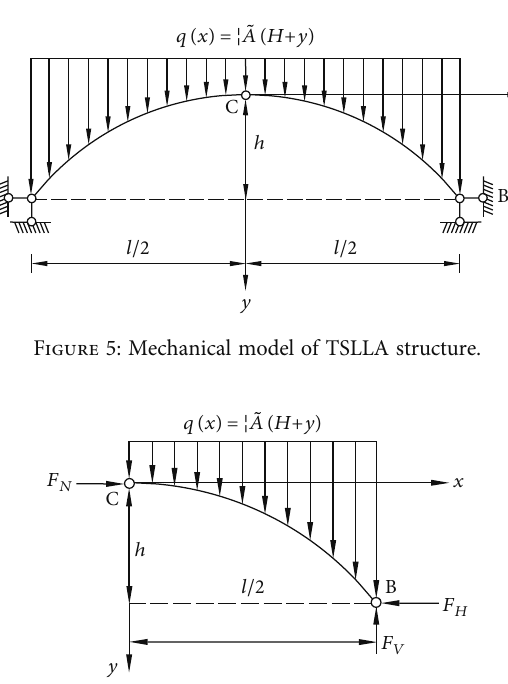
Figure 6: Mechanical analysis chart of arch structure.